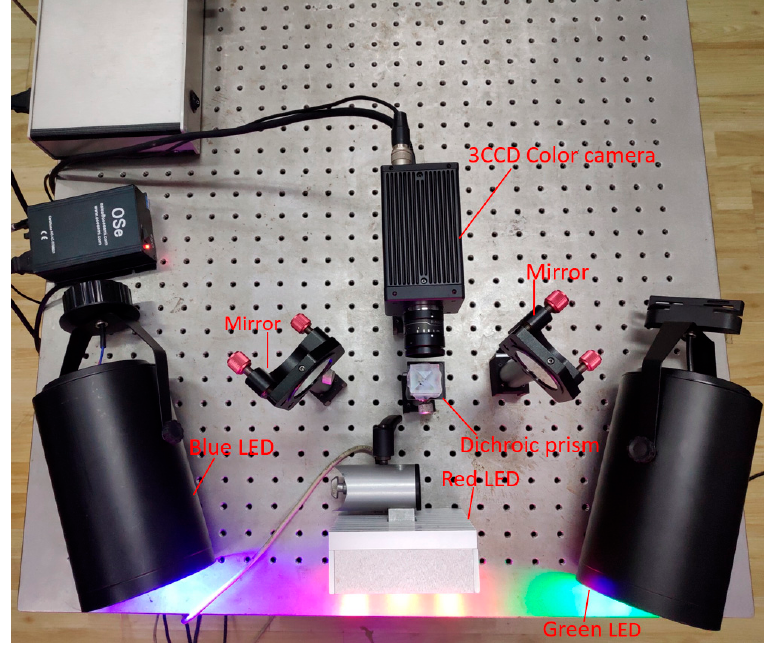
Figure 4. Experimental setup of the improved multi-perspective 3D-DIC system.